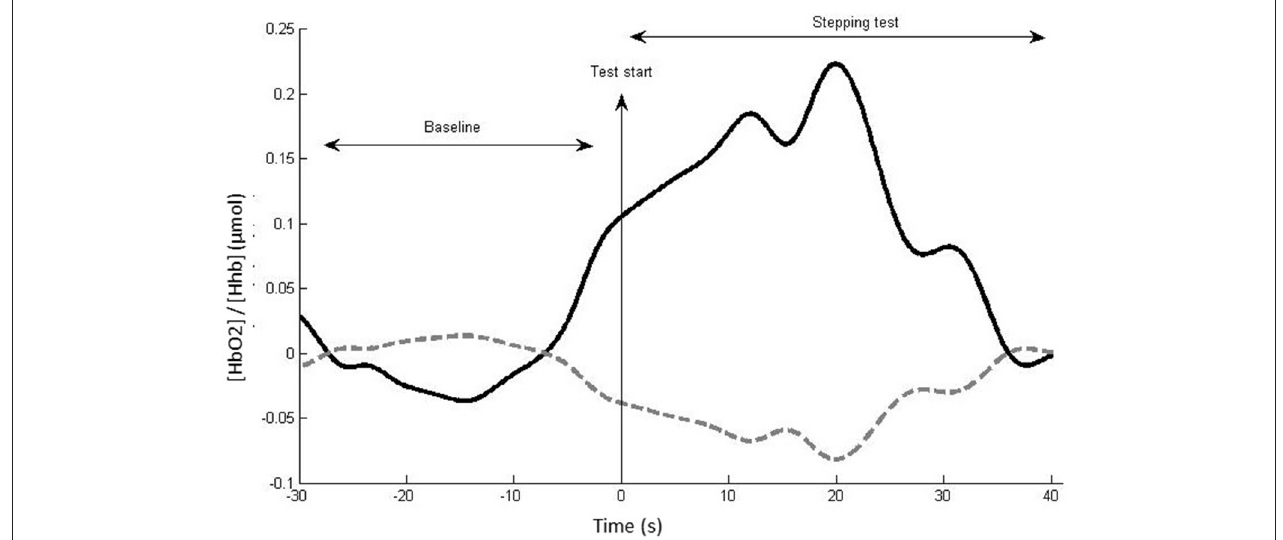
FIGURE 2 | Example of hemodynamic response, with (HbO 2 ) (thick black line) and HHb (dotted gray line) for a single channel, participant, and task. The mean (HbO 2 )/(HHb) change between the baseline and test period reflects the neural activity induced by the test condition in this channel.